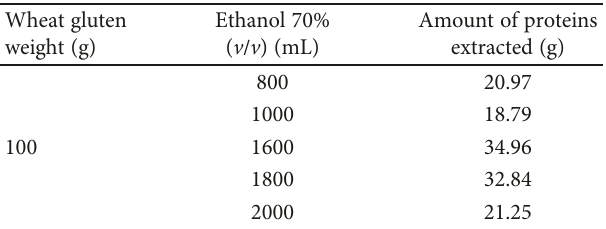
Table 1: Standardization of the extraction of proteins soluble in ethanol 70% ( v/v ) from wheat